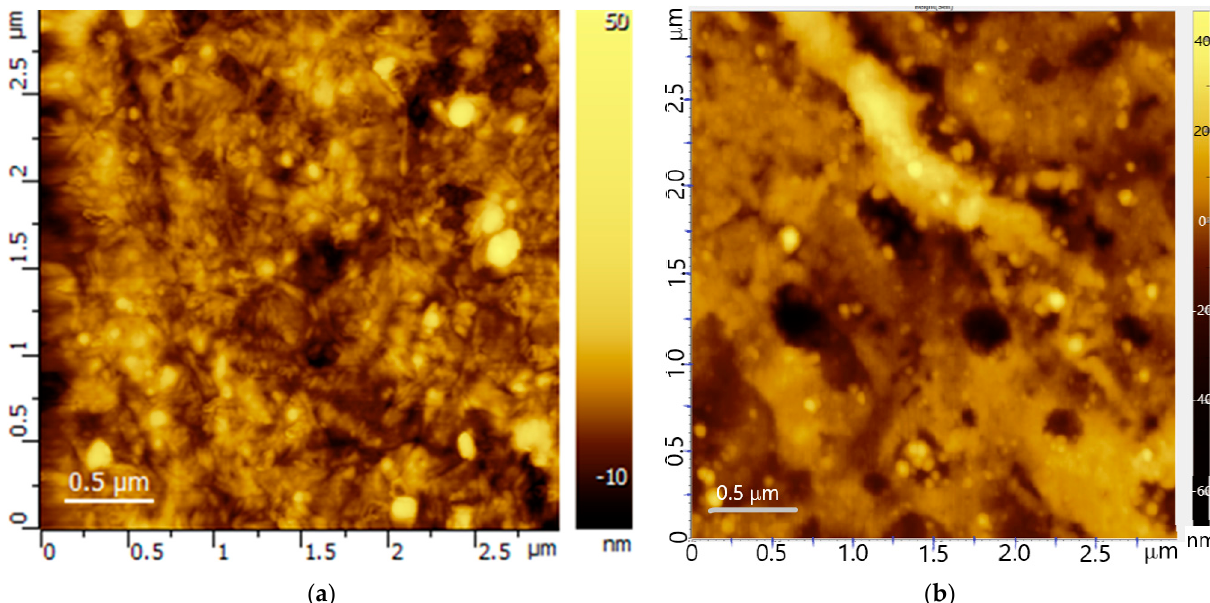
Figure 3. AFM images of the of the PTMSP surface ( a ) and the MF-4SC surface ( b ) of the bilayer composite membrane (3 μ m × 3 μ m) in semi-contact mode.